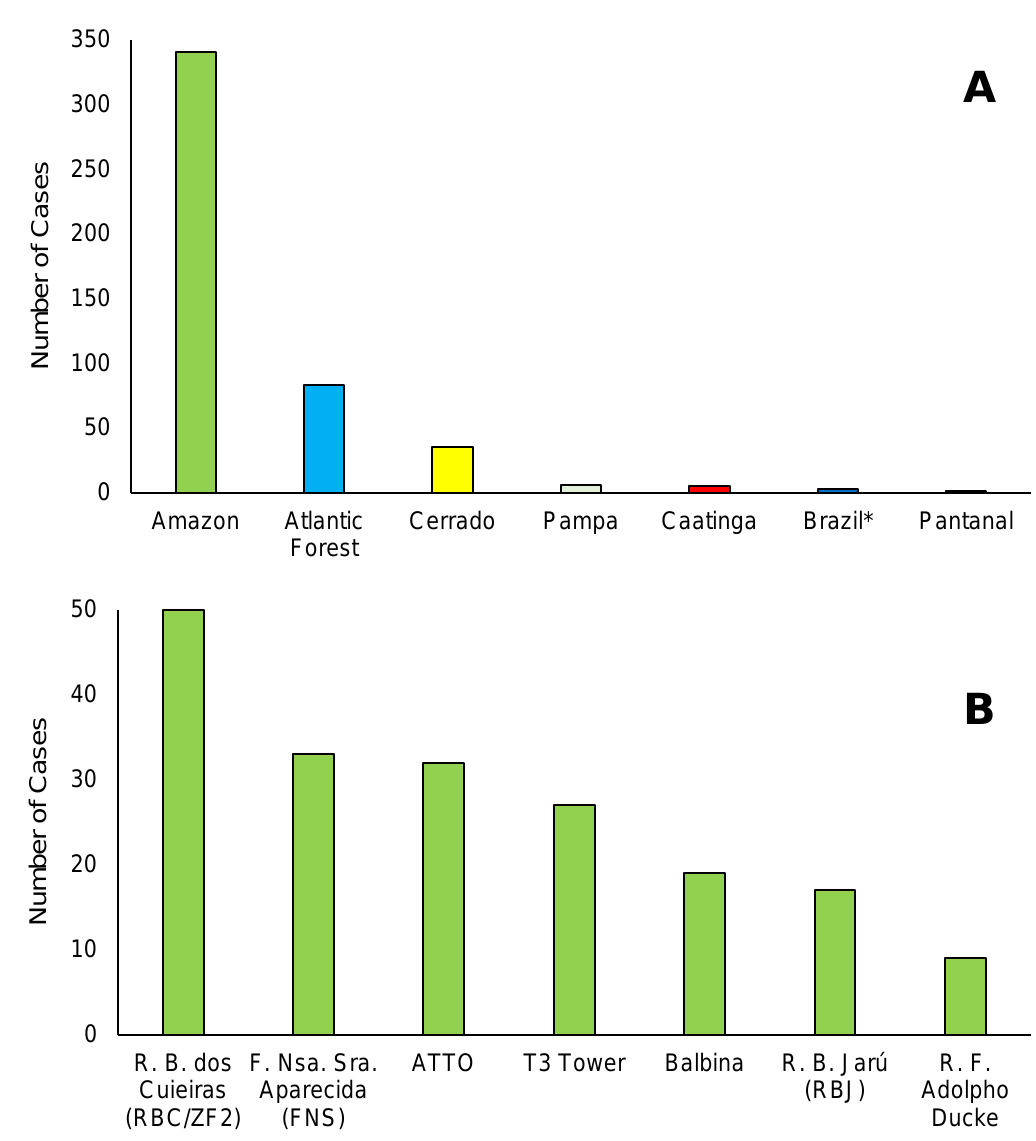
Figure 4. Total number of cases retrieved in our systematic review of the literature on in situ aerosol – PBAP research in Brazil distributed by Brazilian biomes ( A ) and total number of cases carried out within the Amazonian biome distributed by high-interest sites ( B ). Legend: “Reserva Biológica do Cuieiras”; “Fazenda Nossa Senhora Aparecida”; ATTO, Amazon Tall Tower Observatory; T3 Tower; “Balbina”; “Reserva Biológica do Jarú”; and “Reserva Florestal Adolpho Ducke”. Note: * refers to studies that were performed using airplanes spanning an area bigger than only one biome.